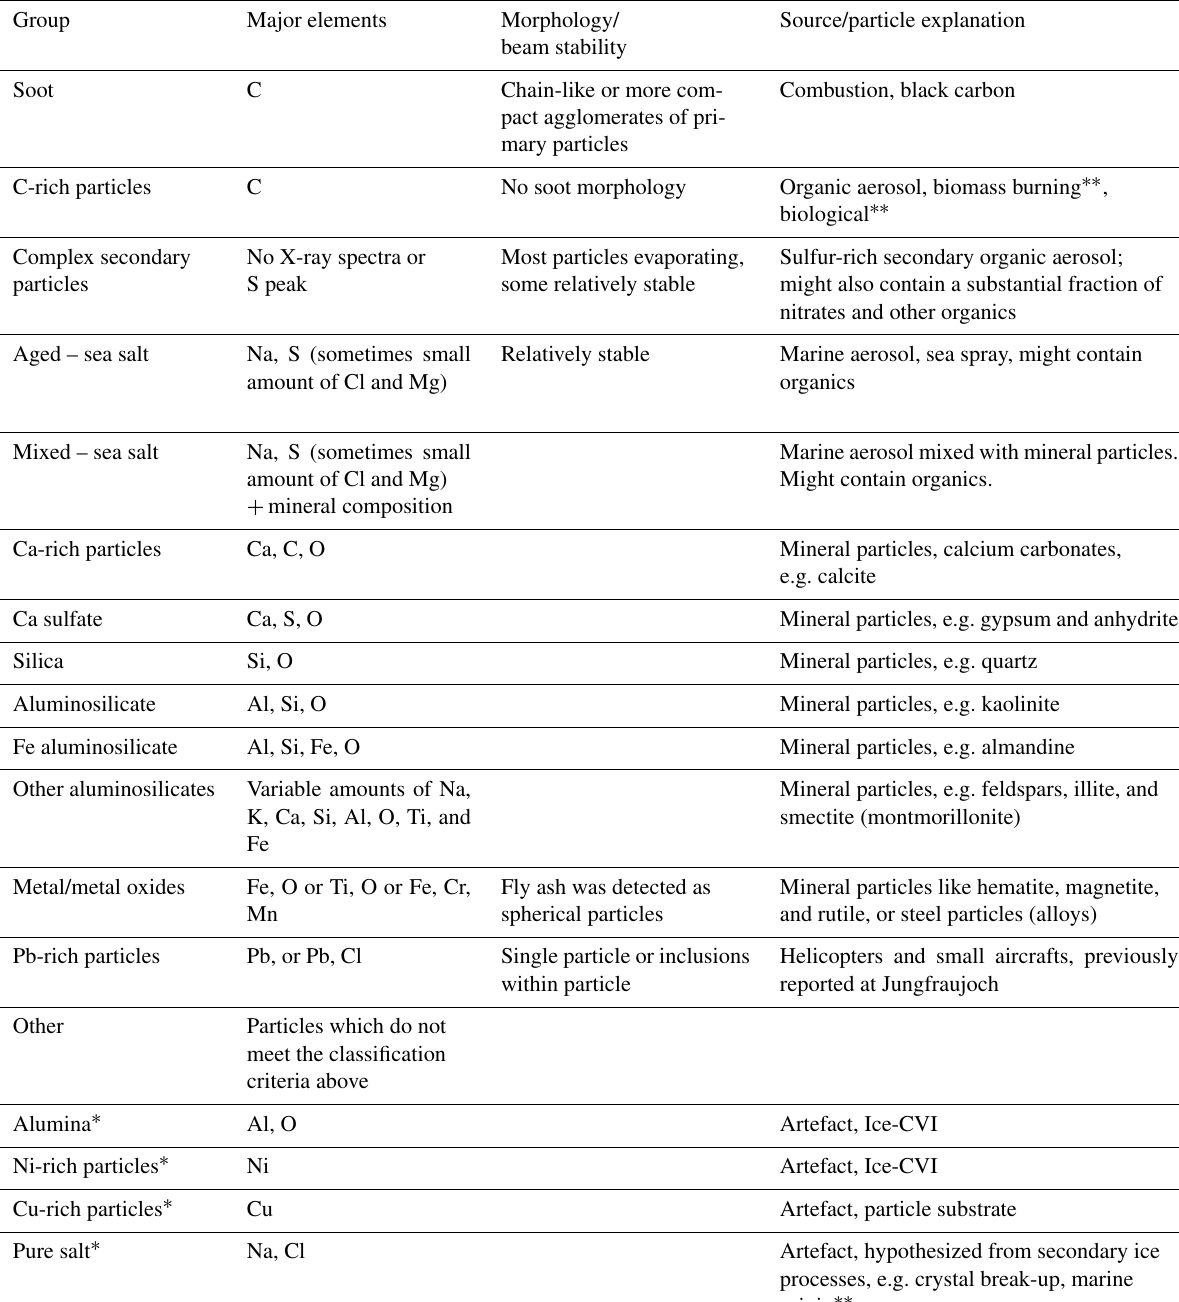
Table 1. Classification criteria and possible sources/explanations for particle groups for both total aerosol and ice particle